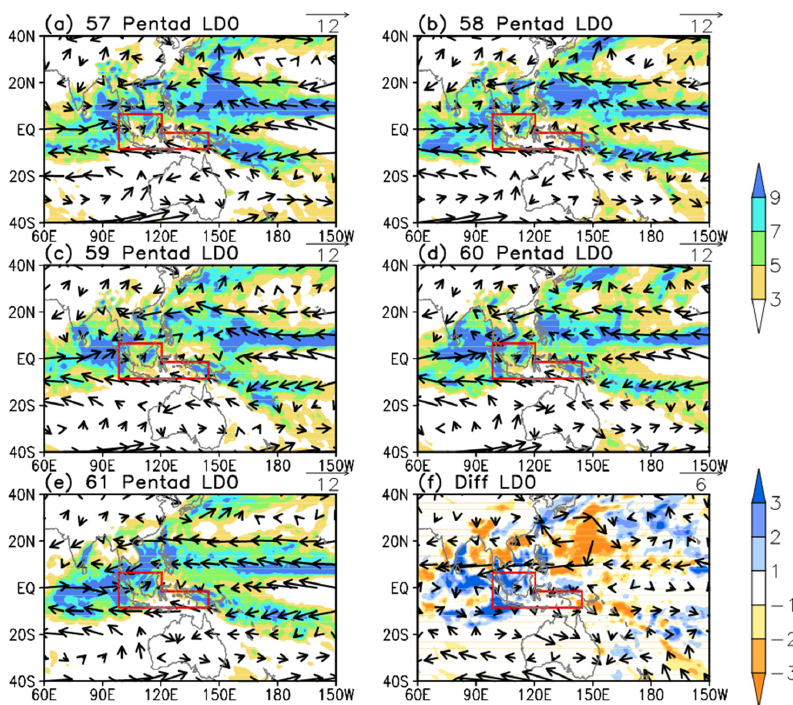
Figure 8. Same as in Figure 5, but for CFSv2 LD0. ( a ) 57th pentad; ( b ) 58th pentad; ( c ) 59th pentad; ( d ) 60th pentad; and ( e ) 61st pentad; ( f ) Differences between 60th–61st pentad mean and 57th–58th pentad mean. The domain of the Maritime Continent is outlined with red boxes.